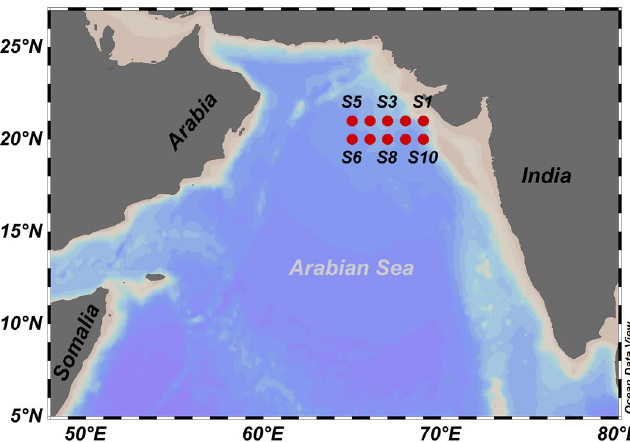
Figure 1. Map of the Arabian Sea showing sampling locations (S1 to S10). Map created in ODV 57